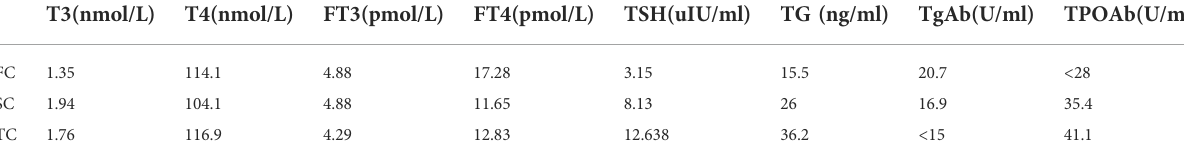
TABLE 2 Thyroid function changes during neoadjuvant therapy cycles.